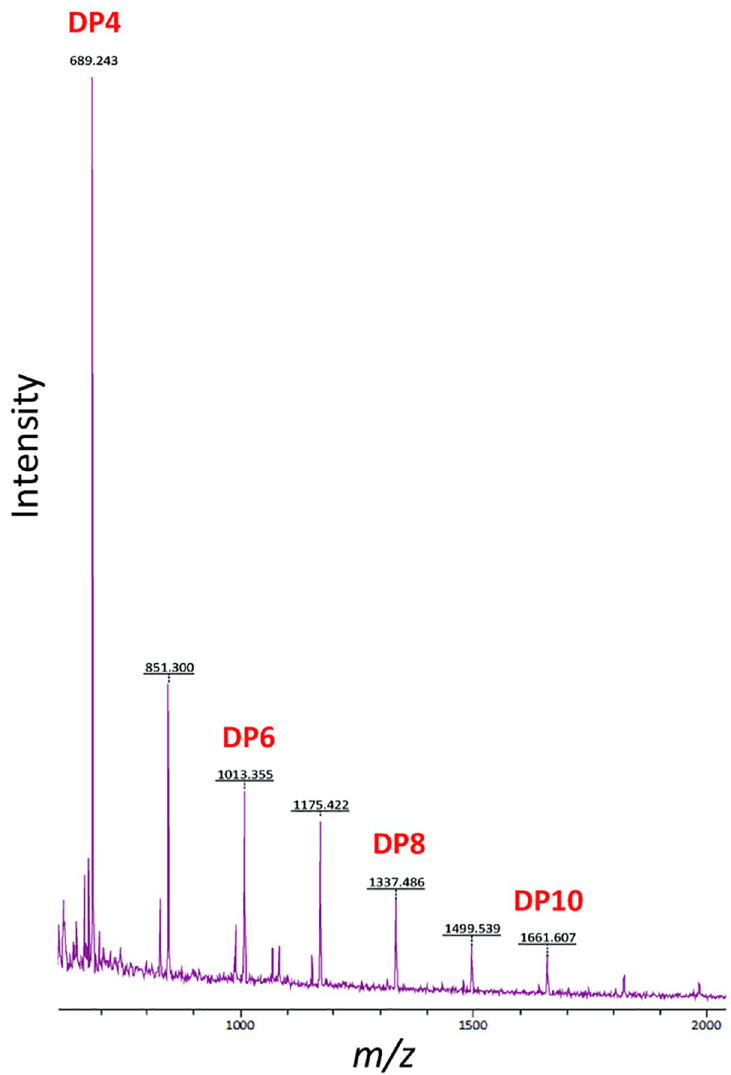
Fig 7. PAO1 GlgX is a debranching enzyme with a short chain length specificity. GlgX was incubated with rabbit liver glycogen that is composed of linear chains with an average DP of 10.8 ± 4.6. The resulting reaction mixture was analysed using MALDI mass spectrometry. The DP of the liberated linear maltooligosaccharide products is shown, with maltotetraose being the major product